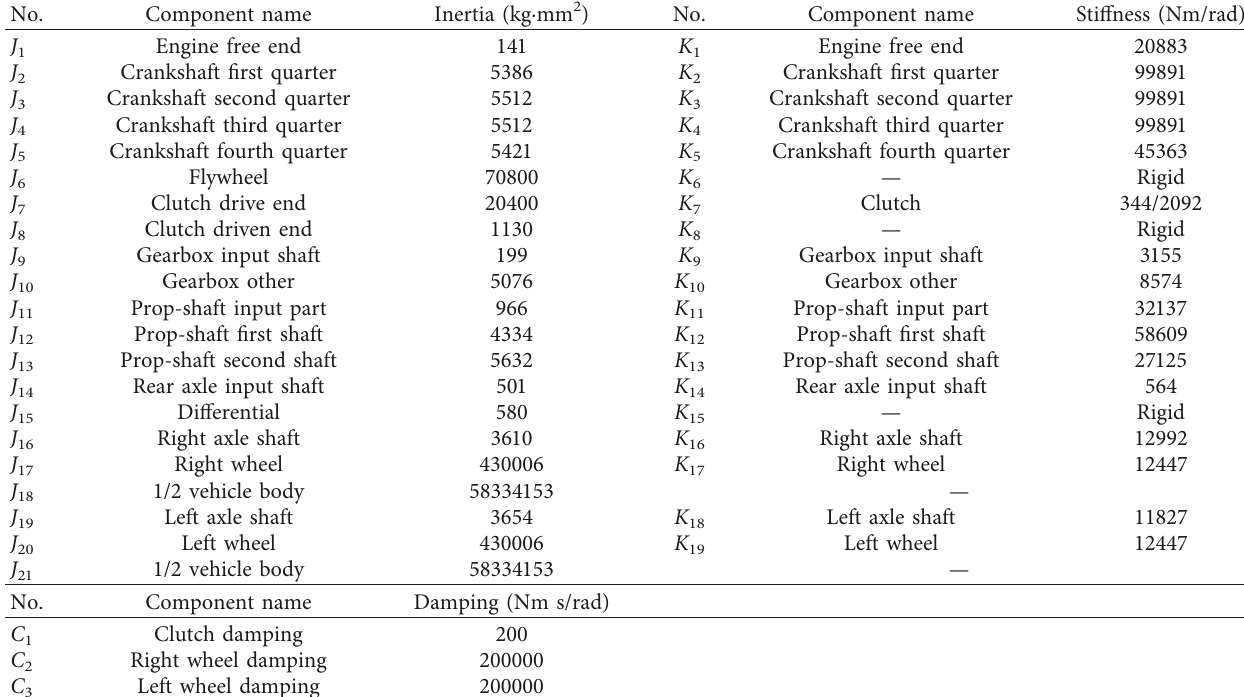
Table 5: Lumped parameters of minivan drivetrain.